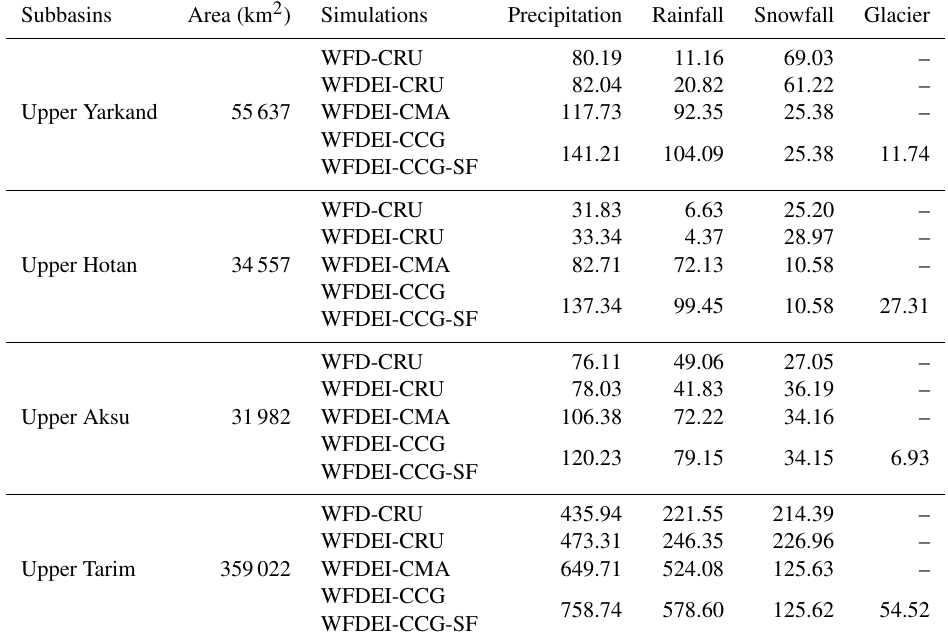
Figure 4. The interannual cycle and intra-annual series of the precipitation (including rainfall, snowfall and glacier) in difference simulations for the upper Tarim Basin. Table 3. The five simulations in this study and basic diagnostics of the water inputs over three headwater catchments and the upper Tarim Basin. Units: 10 8 m 3 yr − 1 . Precipitation Rainfall Snowfall